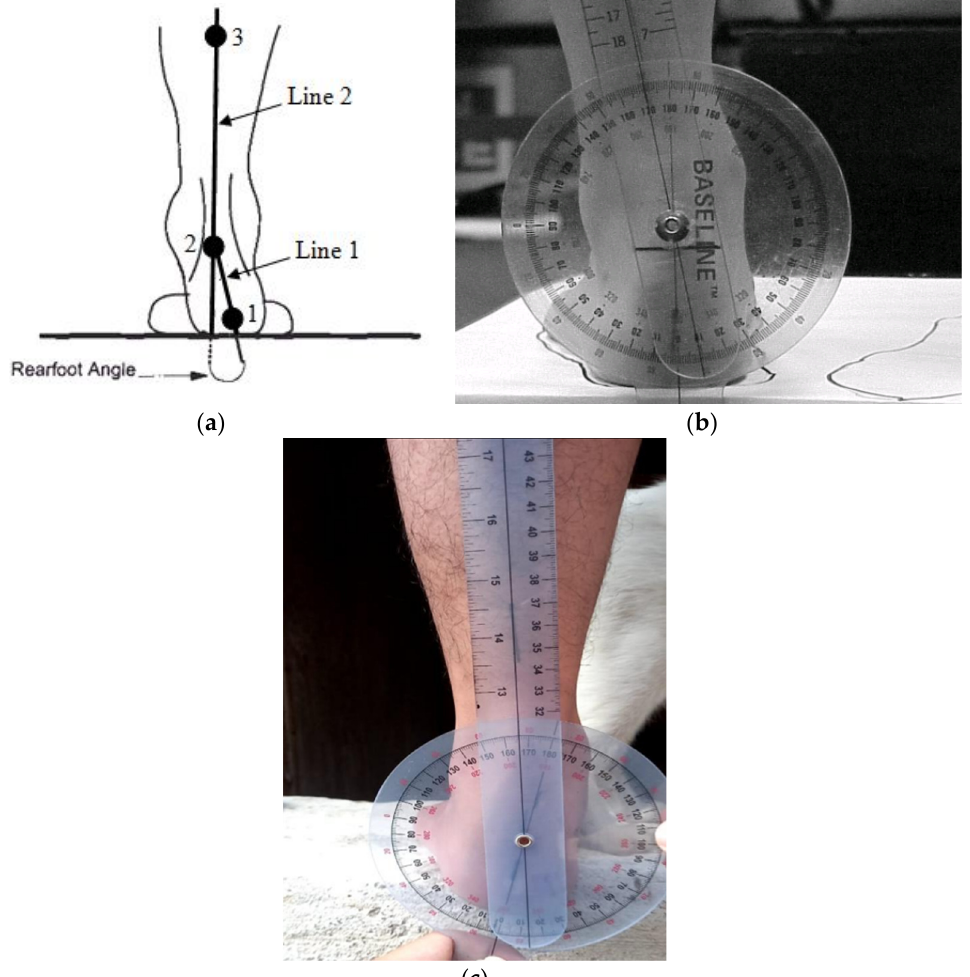
Figure 3. Measuring the RFA: ( a ) schematics measurement; ( b ) manual measurement; ( c ) an example of actual RFA measurement in this study.